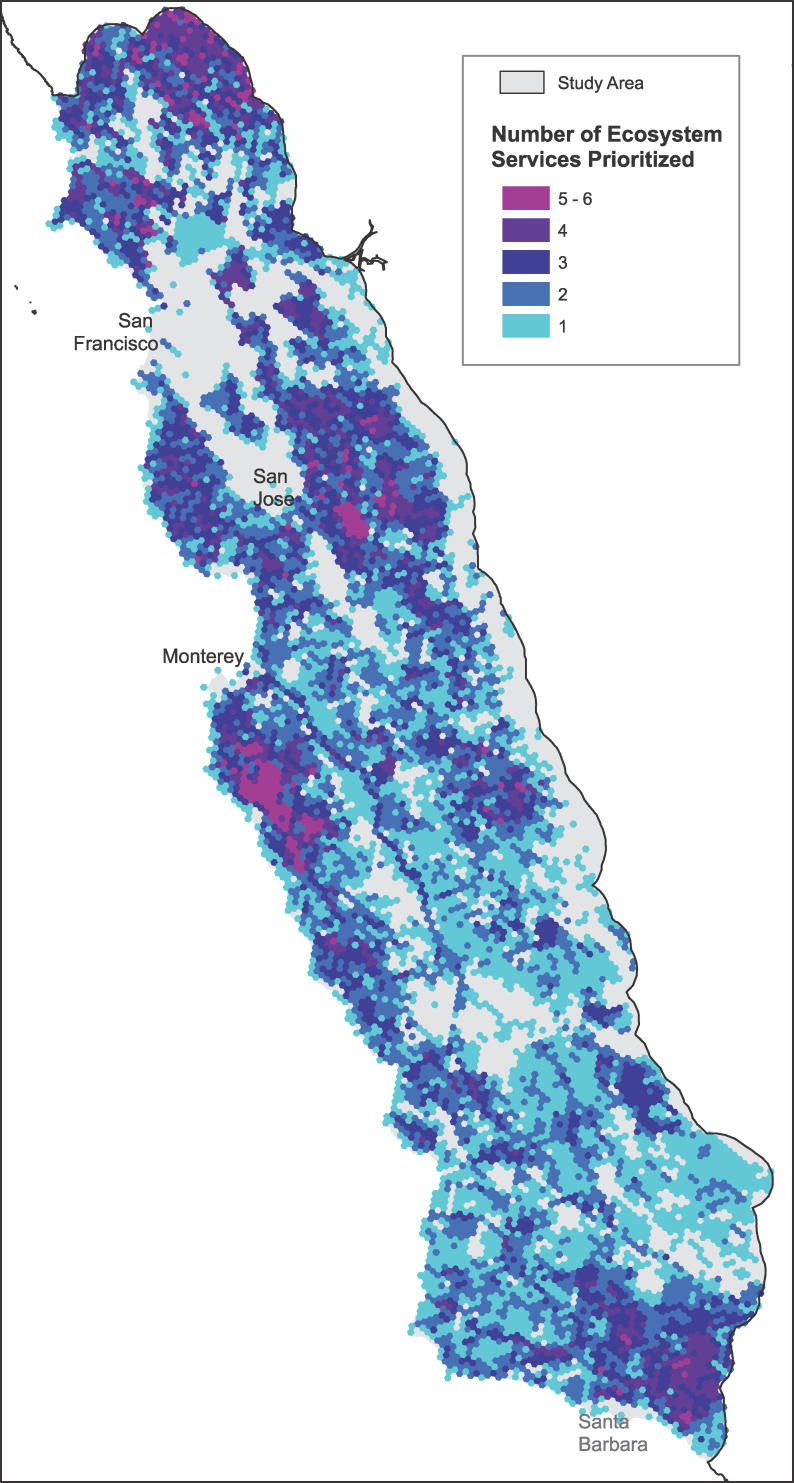
Ecosystem Service and Biodiversity HotspotsColors represent the number of features for which each planning unit was selected in the individual-service best MARXAN network. We selected 1.8% of planning units for ≥5 features and 8.5% for ≥4.